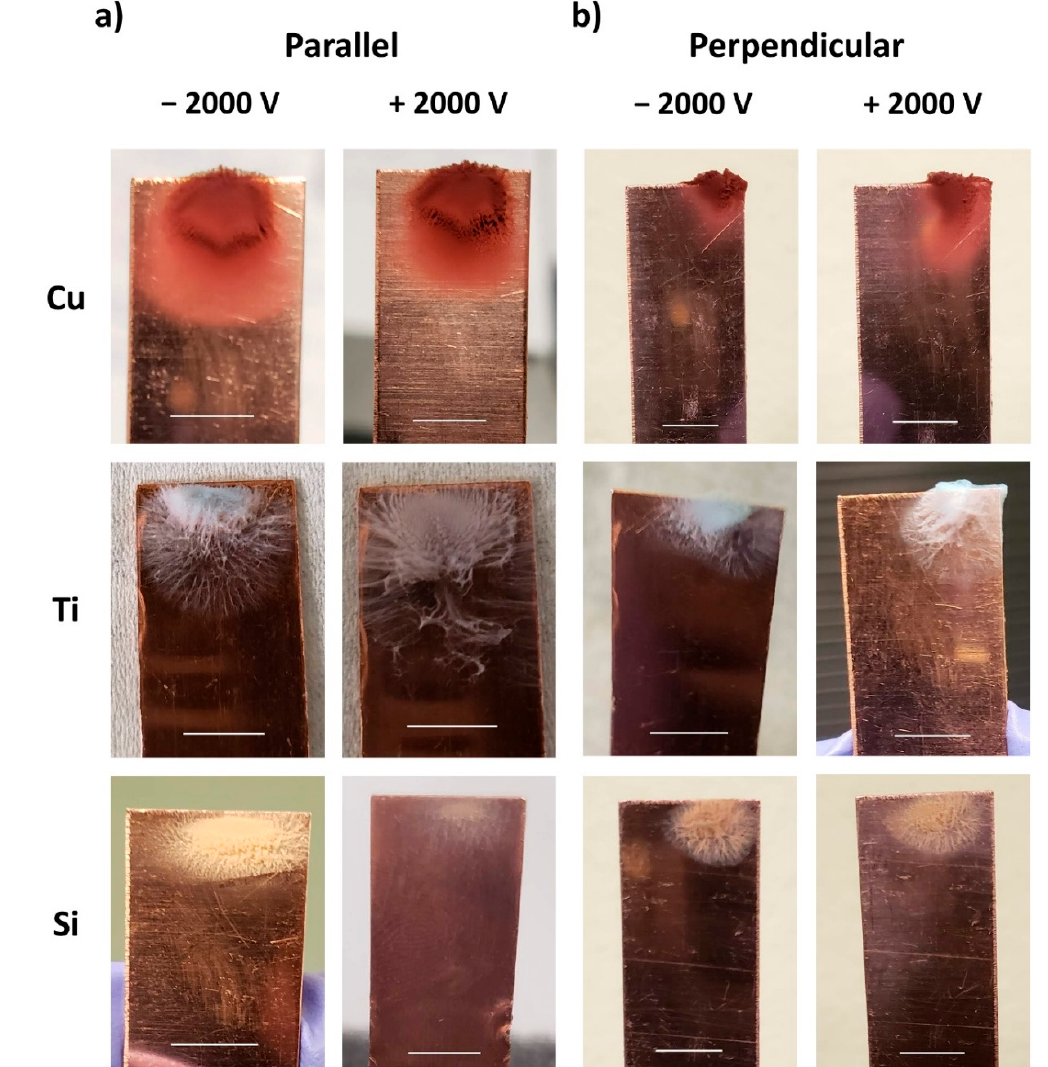
Figure 7. Photographs of the Cu collection plate after the process of laser machining in the ( a ) parallel and ( b ) perpendicular laser scanning direction under the floating potential condition. The scale bars correspond to 5 mm.